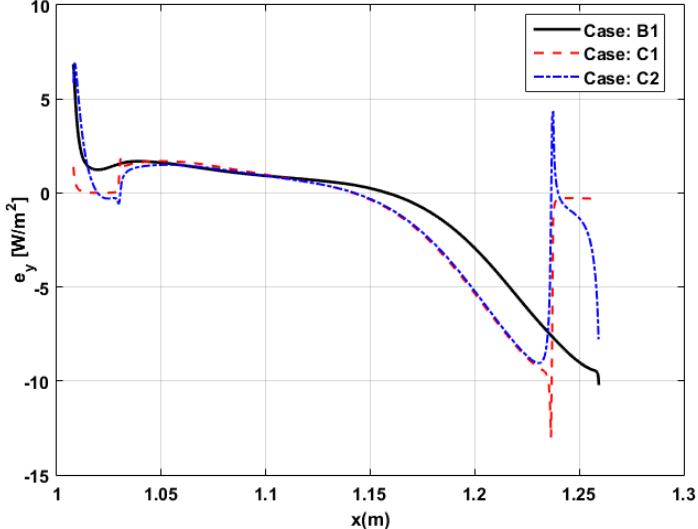
(cid:104) . e (cid:105) y t distribution, after 30 s, for Celcor based material Figure 7. 〈𝒆̇ 𝒚 〉 𝒕 distribution, after 30 s, for Celcor based material combinations. Figure 7.